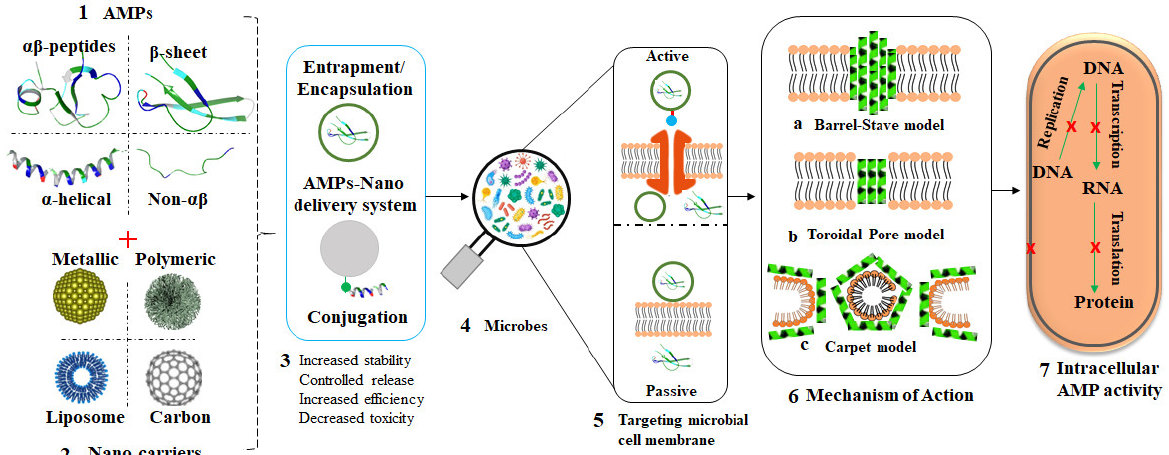
Figure 5. Overview of AMP-loaded nanocarriers and their mode of action. Structurally, AMPs are classified into four groups (1); different nanocarriers have been studied as effective carries of AMPs (2); different AMP nanoformulations can be obtained through various chemistries between peptides and nanocarriers (3); exposure of microbes to these AMP nanoformulations (4); via passive or active transportation (5); leading to bacterial membrane attack by the AMPs through various AMP-dependent mechanisms (6) and ultimately bacterial death (7).